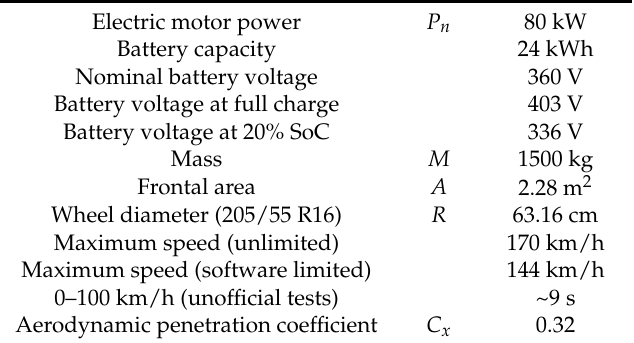
Table 1. Application example: electric vehicle parameters. SoC—state of charge.